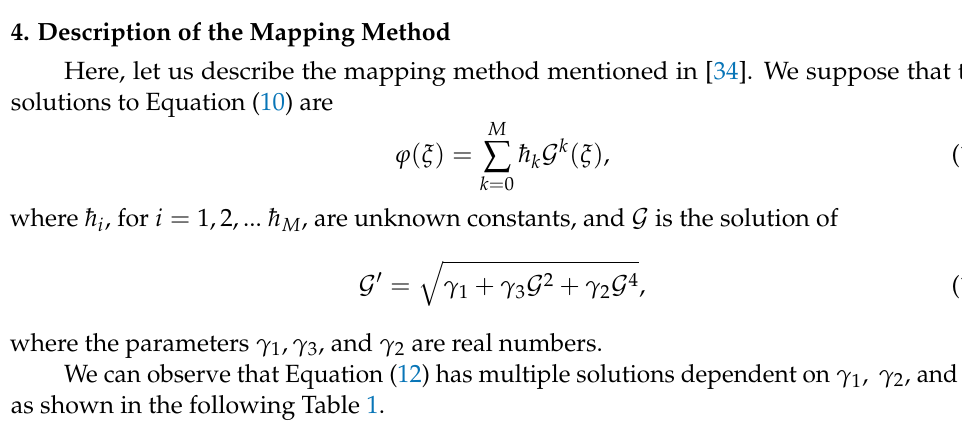
Table 1. All solutions for Equation (12) for different values of γ 1 , γ 2 , and γ 3